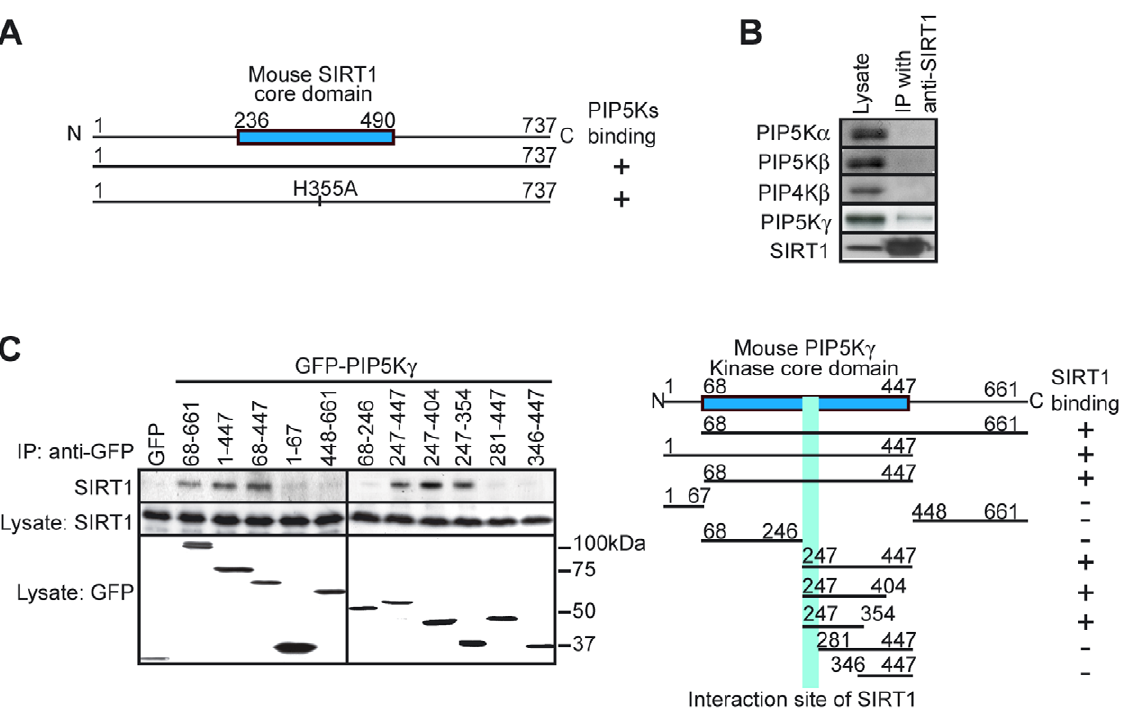
Figure 3. Identification of PIP5K c as a SIRT1-binding protein. (A) PIP5Ks were identified as SIRT1-associated protein by immunoprecipitation with anti-FLAG antibodies from HEK293T cells expressing FLAG-SIRT1. A full-length SIRT1 and inactive form of SIRT1 (H355A) interacted with PIP5K ( + ). (B) Immunoprecipitation analysis of endogenous SIRT1 and endogenous PIP5K a , PIP5K b , PIP5K c , or PIP4K b in HEK293T cells. (C) Mapping the interaction interface of SIRT1 with PIP5K c . A schematic representation of the SIRT1 interaction site (right panel; positive ( + ), negative ( 2 )).